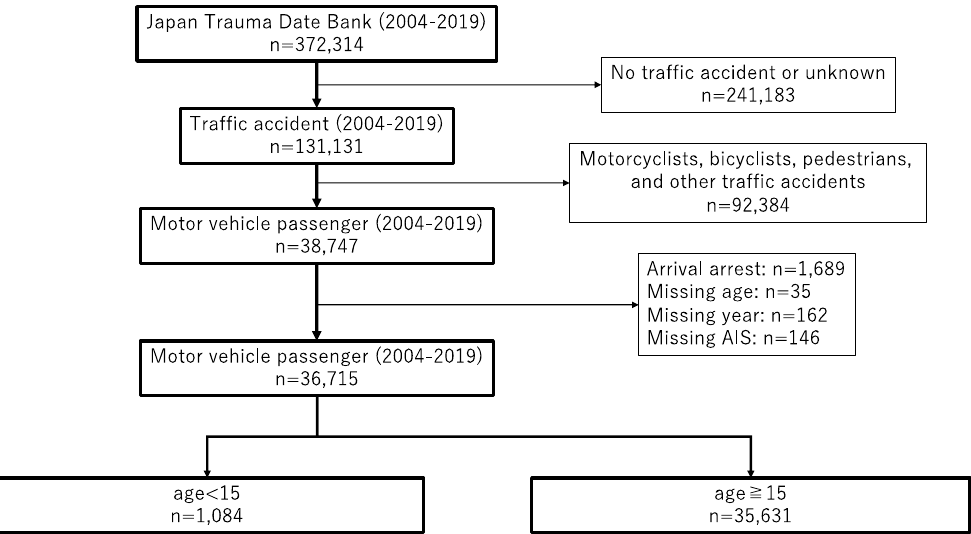
Figure 1. Flowchart of patient enrollment.